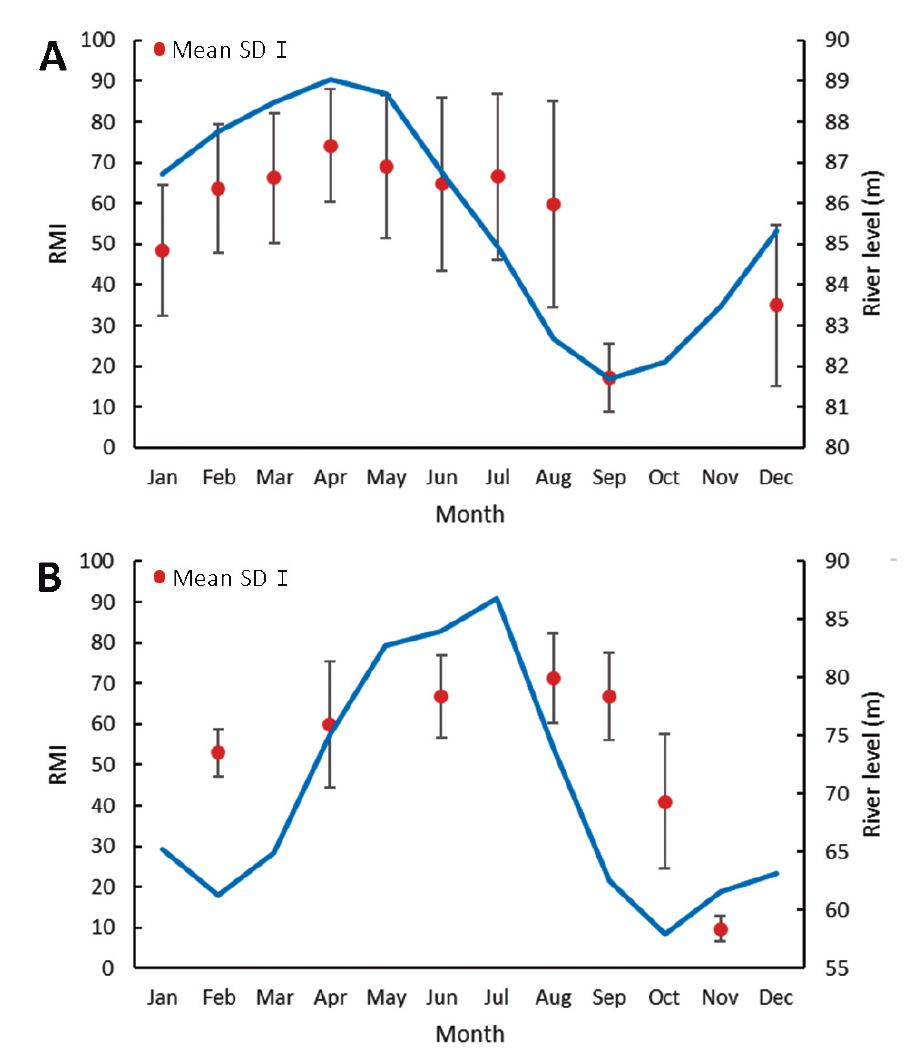
FIGURE 5 | Mean monthly relative marginal increment (RMI ± SD) of Pseudoplatystoma punctifer vertebrae in relation to the hydrological cycle in the A . AMU system and B . Putumayo River. The illustrated hydrological cycles represent the average monthly values from the period